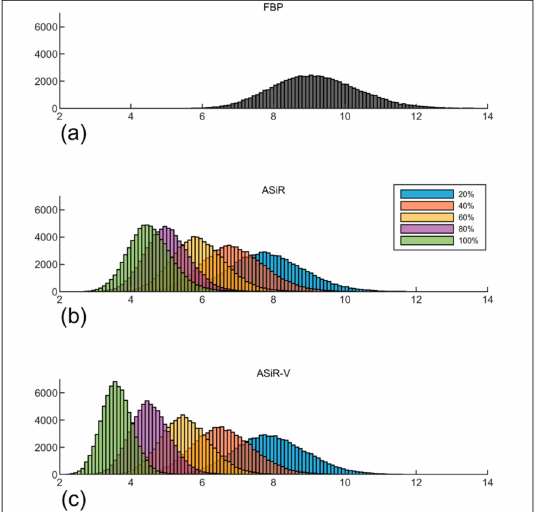
Figure 8. Histograms of noise maps (bin width of 0.1 HU) for FBP- ( a ), ASiR- ( b ), and ASiR-V- reconstructed ( c ) CT images of the homogenous CTP486 module with different blending levels of reconstruction (20%, 40%, 60%, 80%, and 100%). Table 4. Descriptive metrics of noise map histograms for FBP-, ASiR-, and ASiR-V-reconstructed CT images of the homogenous CTP486 module with different blending levels of reconstruction (20%, 40%, 60%, 80%, and 100%). Median and interquartile range values are expressed as HU; kurtosis and skewness values are unitless. Median